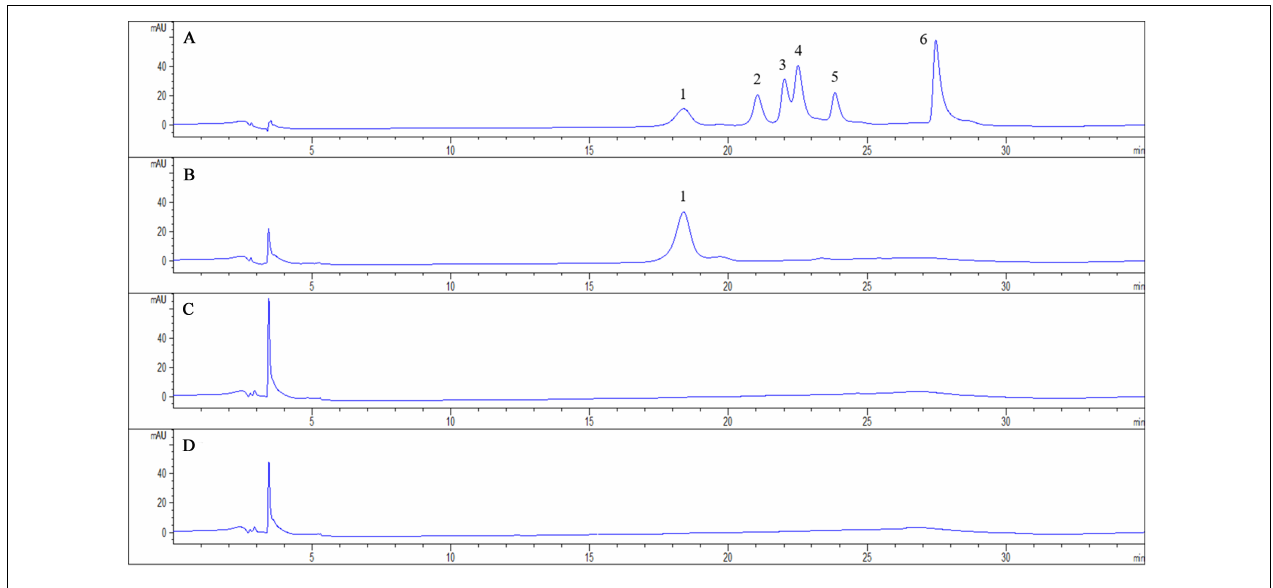
FIGURE 1 | Chromatogram of exudates from tobacco roots and R. solanacearum and their interaction. The chromatograms are of phenolic acids detected with HPLC both in standard chemicals and root exudates collected 3 days post-inoculation from the interaction of tobacco and R. solanacearum . The peaks in (A) represent the following standard compounds: 1, caffeic acid; 2, syringic acid; 3, benzoic acid; 4, p -coumaric acid; 5, ferulic acid; and 6, cinnamic acid. (B–D) represent the chromatograms of the interaction of tobacco and R. solanacearum , R. solanacearum only, and tobacco only, respectively.